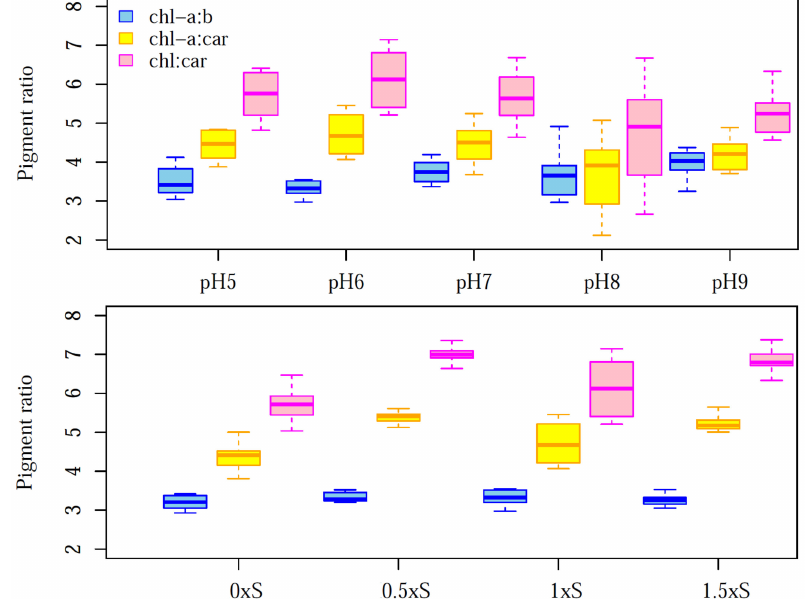
Figure 3. Boxplots of pigment ratios for di ff erent pH conditions or S-strength treatments. A negative correlation was confirmed for chl a :car and chl:car with pH. On the contrary, a positive correlation was confirmed between pH and chl